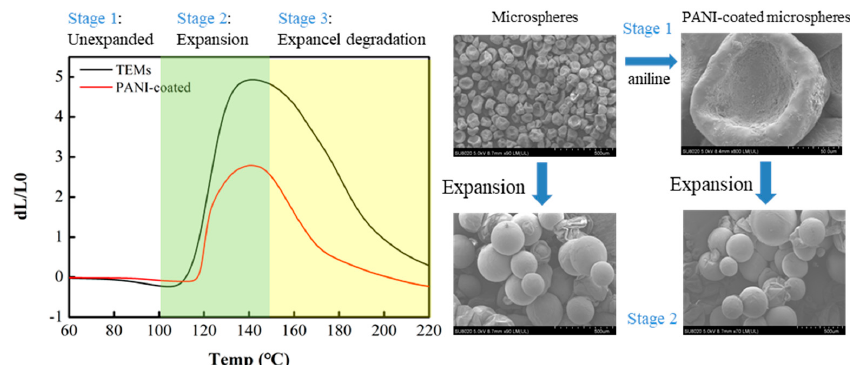
Figure 6. Dilatometer (DIL) curves of uncoated TEMs and polyaniline (PANI)-coated TEMs.